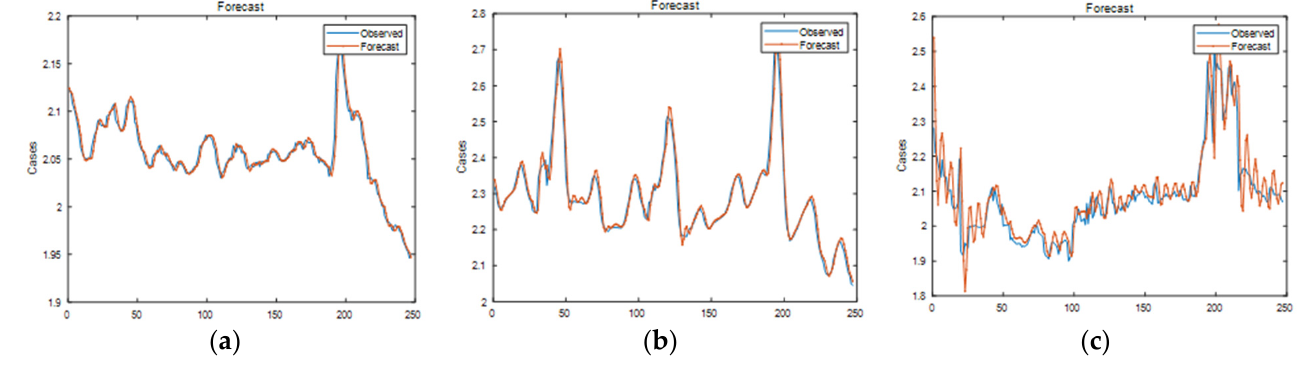
Figure 3. Forecast results. ( a ) the THIRD; ( b ) the BANK; ( c ) the FUND.